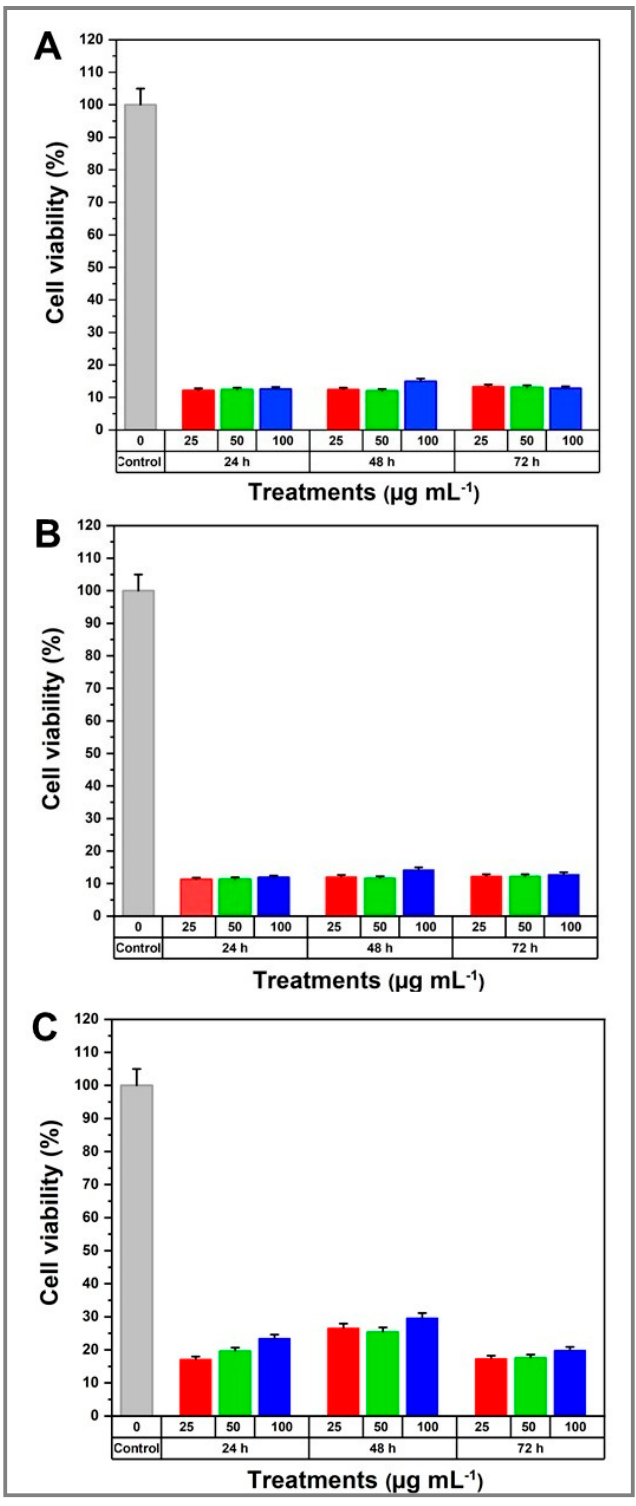
Figure 9. Cell viability of ATCC human fibroblasts exposed to Ag 2 Se NPs at 0, 25, 50 and 100 μ g mL − 1 concentrations for 24, 48 and 72 h. ( A ) Sample E 1 ; ( B ) sample E 2 ; and ( C ) sample E 3 .